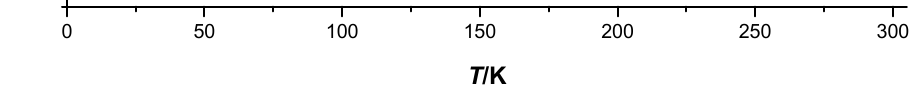
χ Figure 6. χ M T vs T data for the compound C3 . The data are given per dinuclear iron(II) molecule. Figure 6. M T vs. T data for the compound C3 . The data are given per dinuclear iron(II)